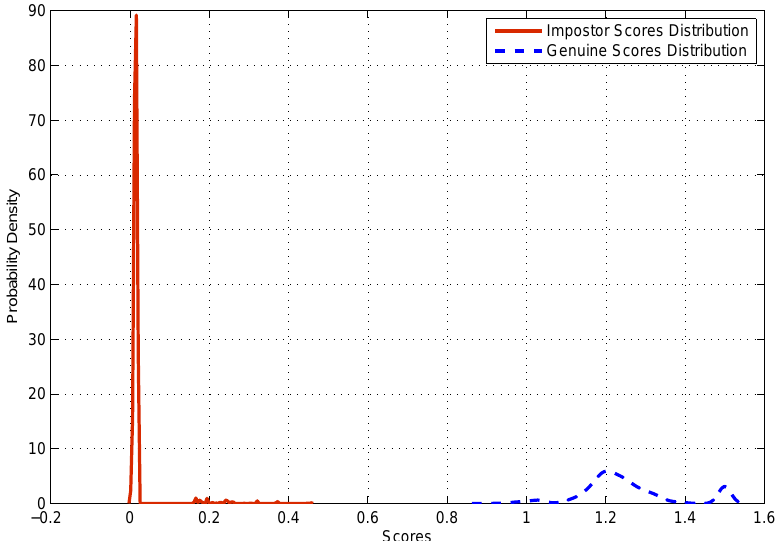
Figure 3. The matching distribution of genuine and impostor scores. To confirm the efficacy of the proposed approach, the false acceptance rate (FAR) and the false rejection rate (FRR) were computed. FRR denotes the proportion of genuine scores that are smaller than the pre-defined threshold (cid:101) ( FRR = p ( S < (cid:101) | genuine ) ), and FAR denotes the fraction of impostor scores that are larger than or equal to (cid:101) ( FAR = p ( S ≥ (cid:101) | impostor ) ). Figure 4 shows that the equal error rate (EER)—which is the point at which the FAR and FRR are equal—of the proposed scheme is 0% when the threshold is 0.4593.